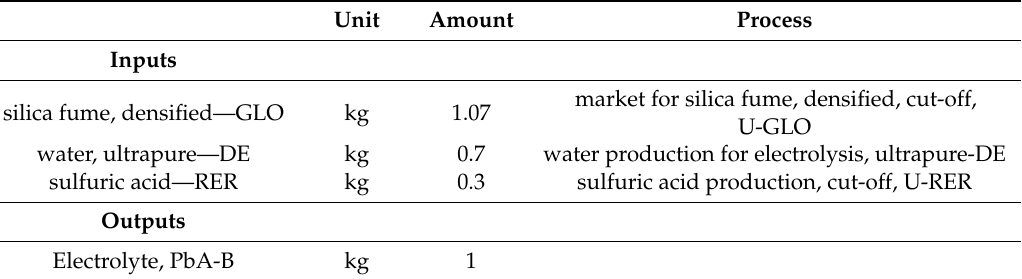
Table A17. Manufacturing Electrolyte, PbA-B.